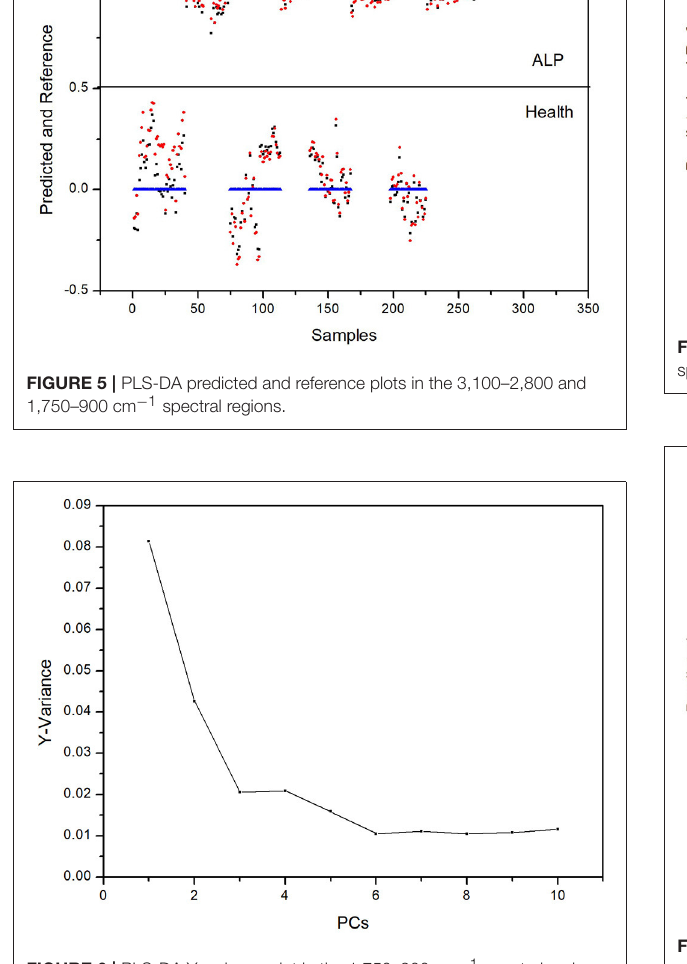
Frontiers in Chemistry |